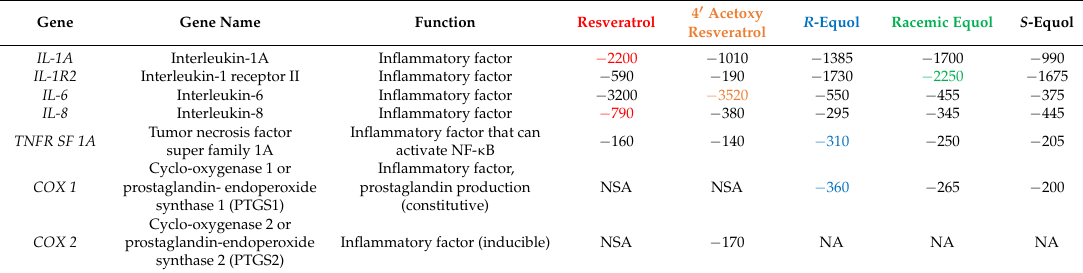
Table 8. Human skin inflammatory factor gene expression among resveratrol, 4 (cid:48) acetoxy resveratrol, R -equol, racemic equol or S -equol as the percentage of the increase (+) or decrease ( − ) compared to